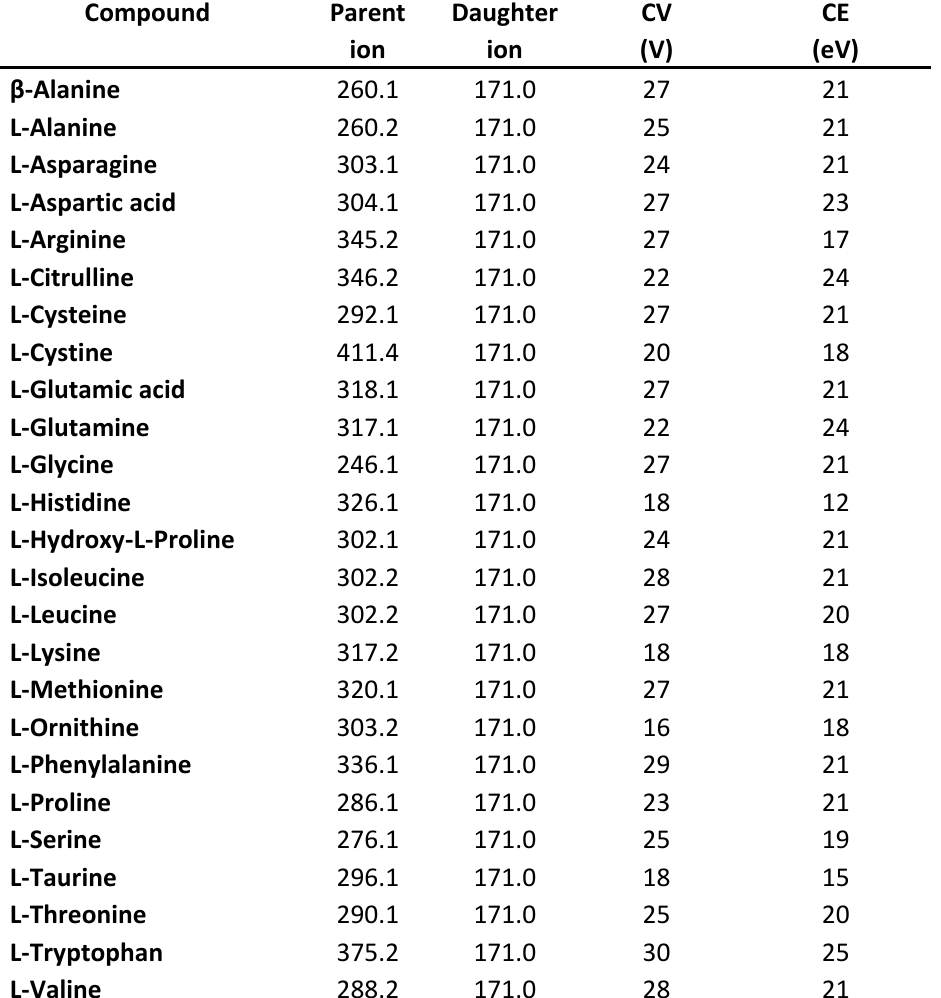
Table 1. MRM transitions, cone voltage (CV) and collision energy (CE) determined for AQC-derivatized standard amino acids buffered with ammonium acetate (50 mM, pH 9.3).